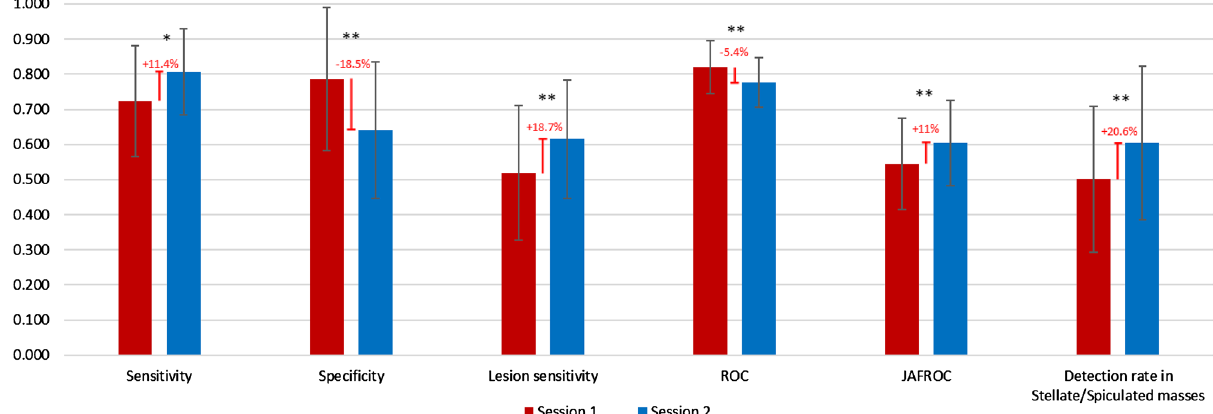
Figure 1. Comparison of radiologists’ performances between two reading sessions (Session 1 with training set and Session 2 with original BREAST test